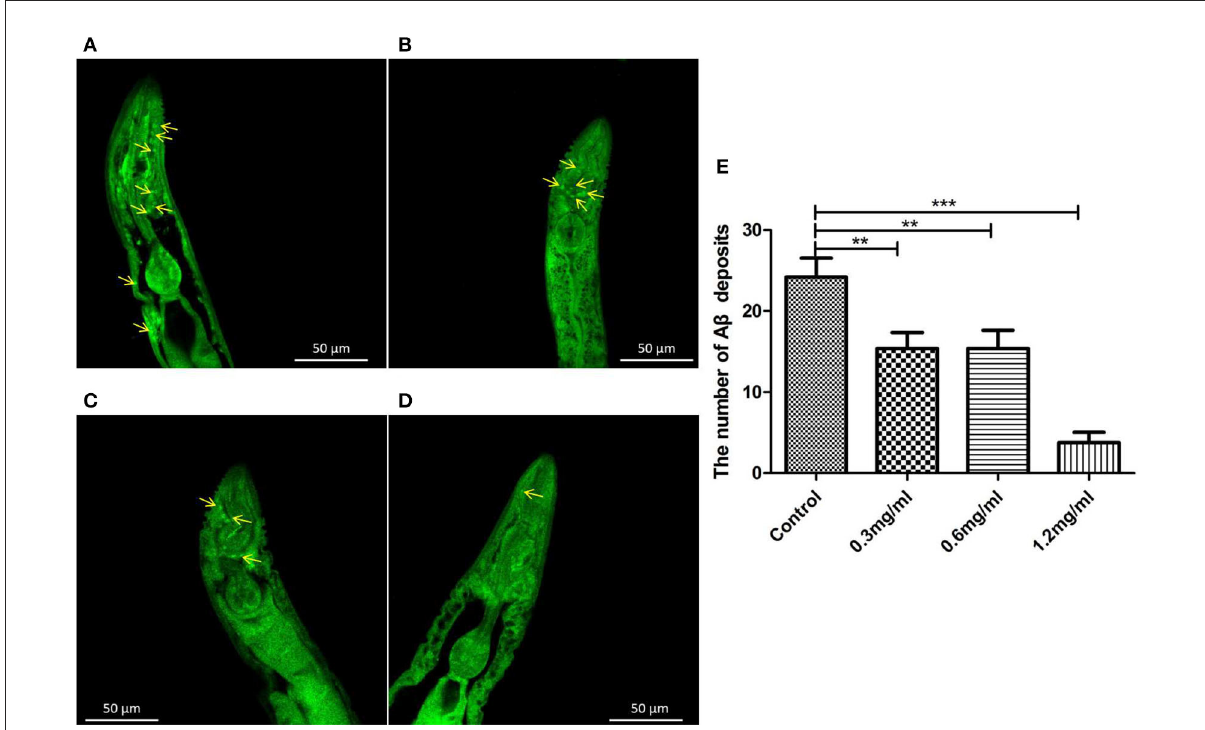
FIGURE5 A β (1-42) accumulation assay with thioflavin T staining in transgenic C. elegans CL4176. (A) Control groups were not treated with Exendin-4. A β (1-42) deposits stained with thioflavin-T show abundant fluorescence patches near the pharynx in transgenic worm CL4176. (B–D) Transgenic worms fed with 0.3 mg/ml, 0.6 mg/ml, and 1.2 mg/ml Exendin-4. They show a significant reduction in the deposition of A β (1-42) in a dose-dependent way. The yellow arrows show the sites of A β (1-42). (E) The number of A β (1-42) patches in different groups. p < 0.01 ( ** ) and p < 0.001 ( ***